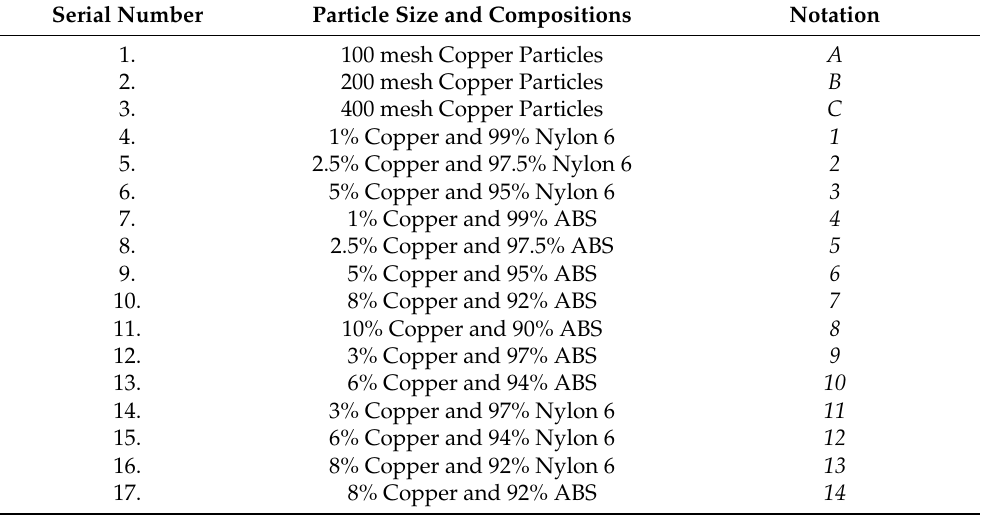
Table 2. Nomenclature of different